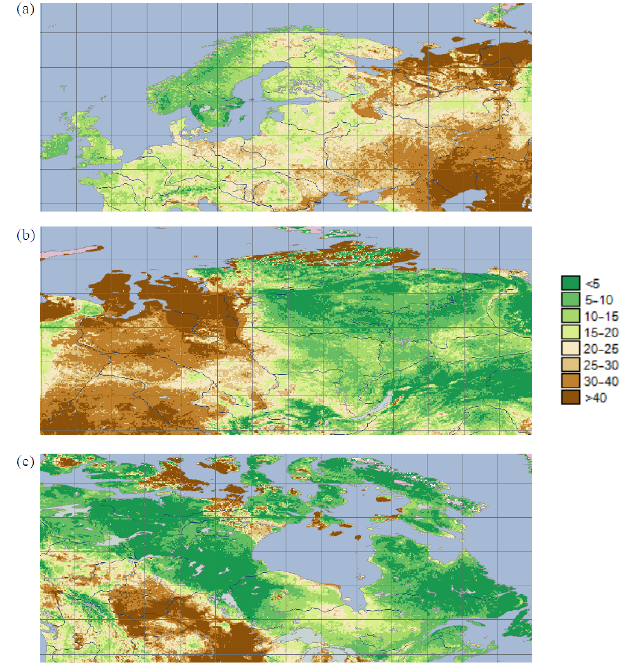
Figure 1. The depth to bedrock, an estimate of g , in meters, in Eu- rope (a) , western Siberia (b) , Canada (c)